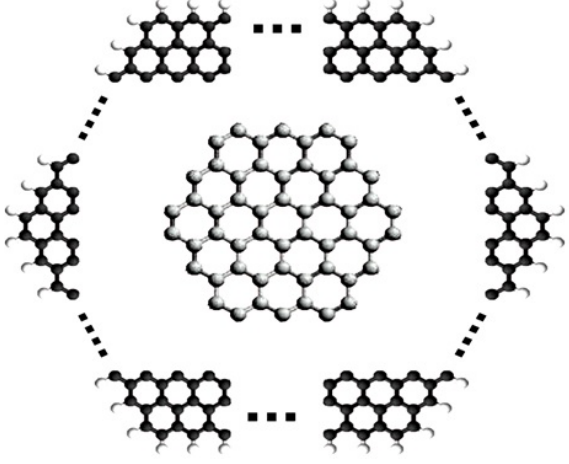
Fig. 1 A general representation of Polycyclic Aromatic Hydrocarbons PAH k